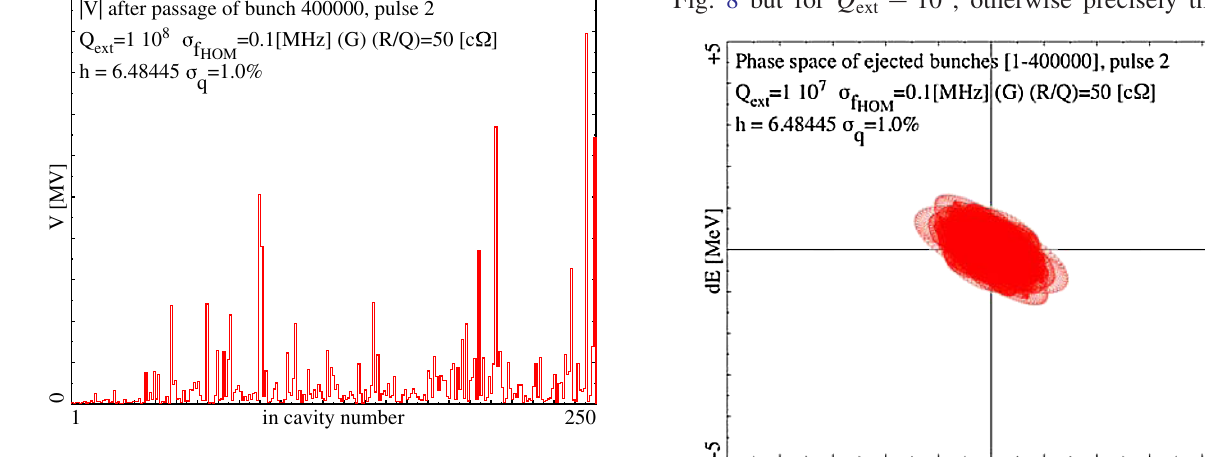
FIG. 9. (Color) The voltage in the 250 cavities after passage of the 2nd pulse; conditions as Fig. 8. The equivalent plots (not shown) for conditions as Figs. 6 and 7 show only small cavity excitation.